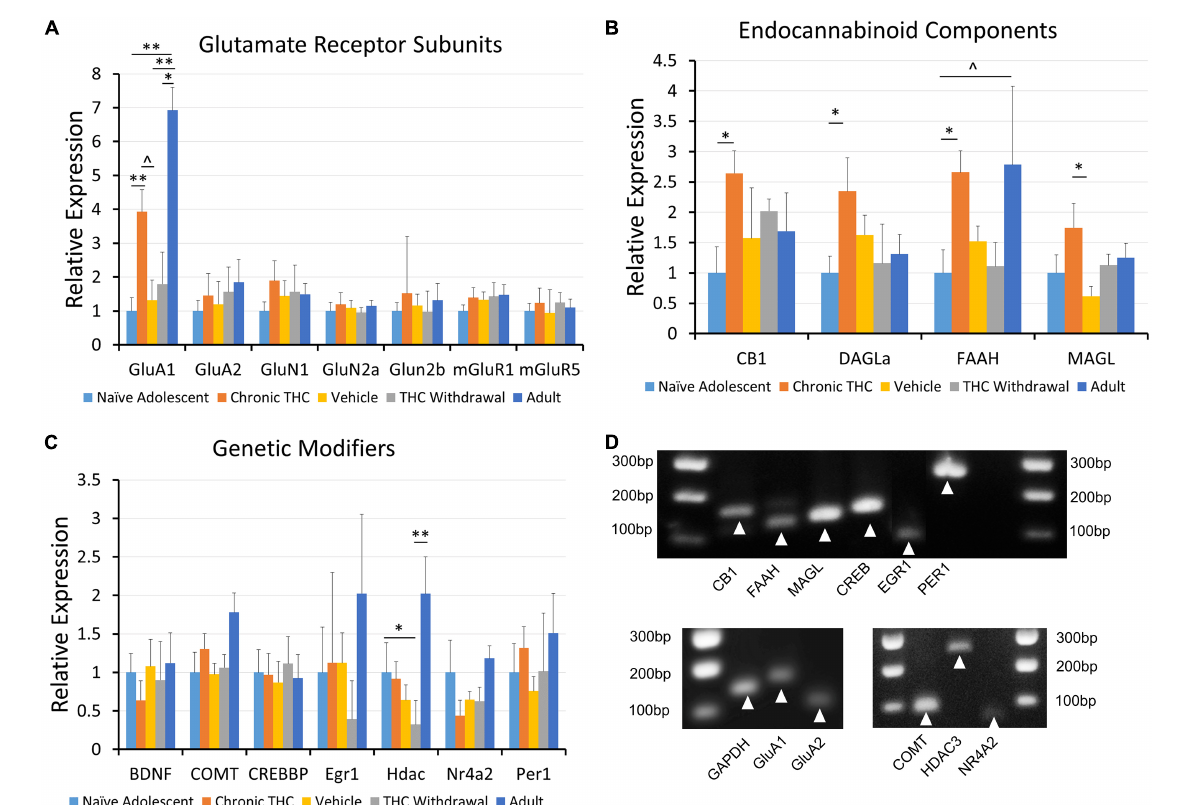
FIGURE4 Expression of mRNA for CB1, GluA1, DAGL α and FAAH is modified following chronic THC injection or development. (A) Glutamate receptor subunits are largely unchanged across all groups, with the GluA1 subunit being a notable exception. GluA1 gene expression is increased following chronic THC exposure compared to naive young mice ( p < 0.05). GluA1 gene expression is also increased in adults compared to naive young mice ( p < 0.001), vehicle controls ( p < 0.05), and THC withdrawal groups ( p < 0.05). (B) Endocannabinoid components exhibit significant changes or trends following chronic THC injection. Gene expression for the CB1 receptor is significantly increased following chronic THC exposure compared to naive young mice ( p < 0.05). DAGL α shows significant ( p < 0.05) increased gene expression following chronic THC exposure, while FAAH demonstrates a trend in Naive adults compared to naïve young mouse levels (0.1 > p < 0.05). MAGL is increased in chronic THC exposed mice compared to vehicle control mice ( p < 0.05). (C) Various genetic transcription or epigenetic modifiers were also examined, where HDAC3 gene expression decreased ( p < 0.05) in young THC withdrawal groups when compared to naive young mice. HDAC3 gene expression is also increased in adults compared to THC withdrawal group ( p < 0.05). (D) Proper amplification of each cellular target was examined using 4% agarose gel electrophoresis to verify amplicon size. See Table 1 for base pair (BP) lengths. Targets not shown in the gel were published previously (Merrill et al., 2015). The n value ranged from 7 to 10 for each group with at least 3 females and 3 males per group, and each n represents one mouse. The range was the result of some failed PCR experiments in some groups, indicated by qPCR results > 20 cycles from the control target, illustrating non-specificity, likely resulting from experimental error. ∗ p < 0.05, ∗∗ p <